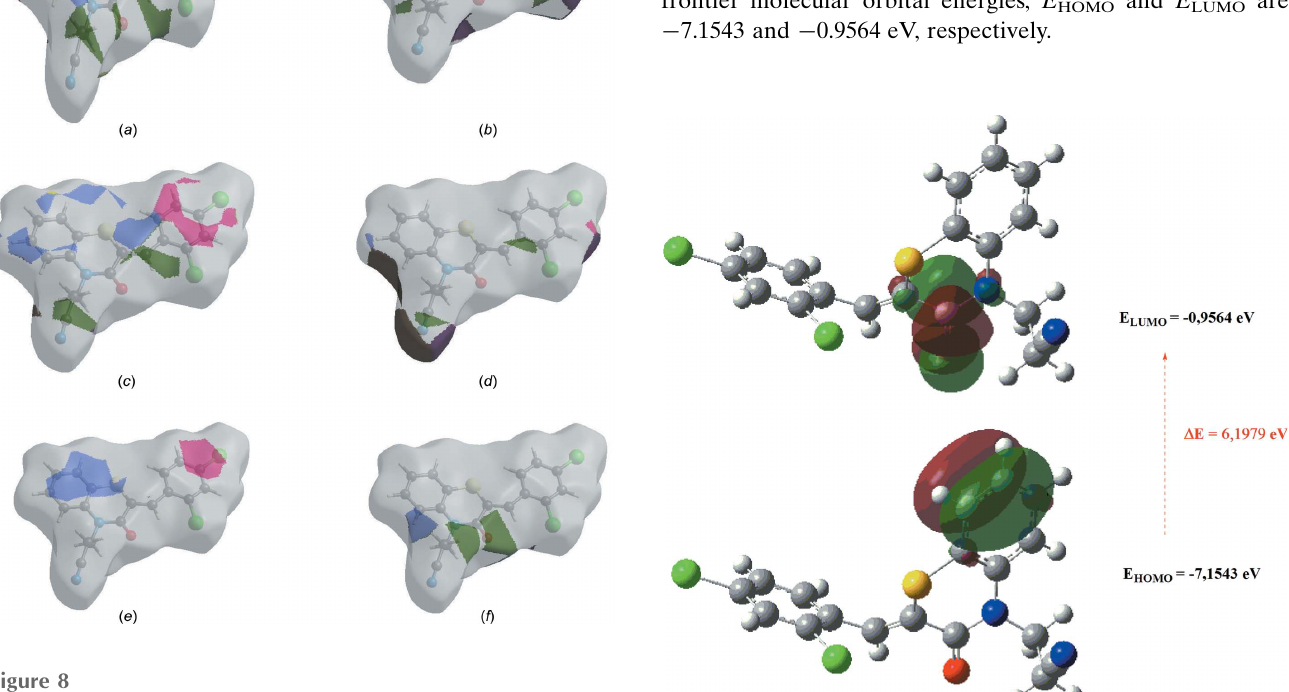
Figure 8 The Hirshfeld surface representations with the function d norm plotted onto the surface for ( a ) H (cid:2)(cid:2)(cid:2) H, ( b ) H (cid:2)(cid:2)(cid:2) Cl/Cl (cid:2)(cid:2)(cid:2) H, ( c ) H (cid:2)(cid:2)(cid:2) C/C (cid:2)(cid:2)(cid:2) H, ( d ) H (cid:2)(cid:2)(cid:2) N/N (cid:2)(cid:2)(cid:2) H, ( e ) C (cid:2)(cid:2)(cid:2) C and ( f ) H (cid:2)(cid:2)(cid:2) O/O (cid:2)(cid:2)(cid:2) H